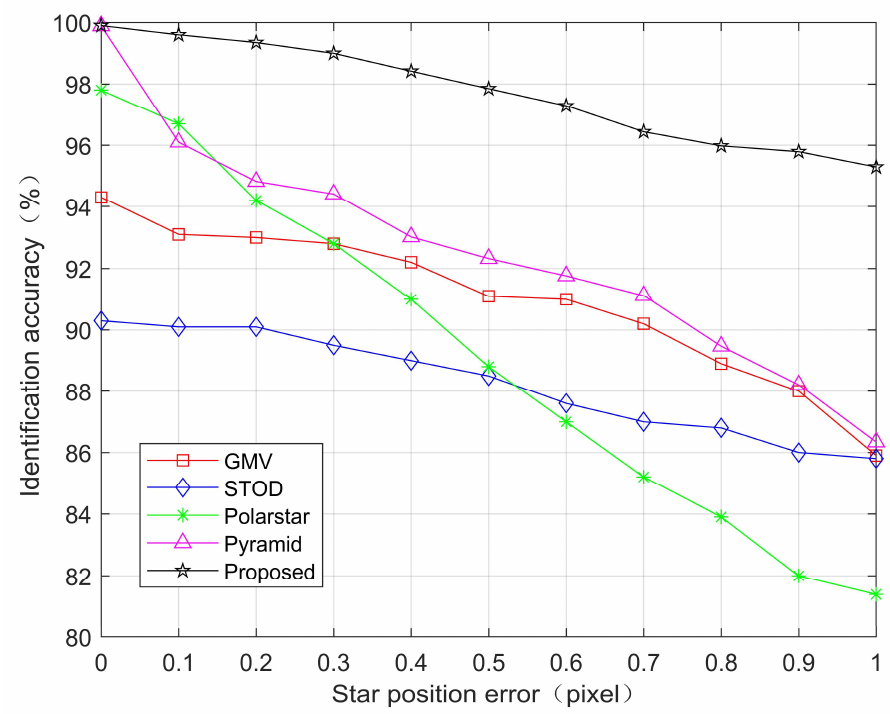
Figure 17. Identification accuracy benchmarking for sensitivity to star positioning errors.